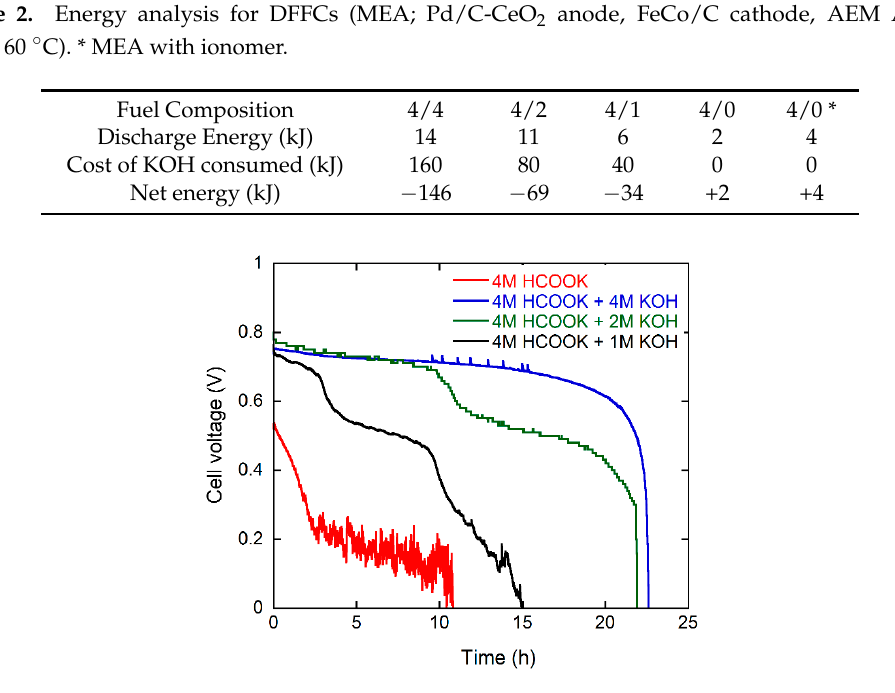
Figure 3. Galvanostatic curves at 50 mA·cm − 2 at 60 °C for the DFFC containing the Pd/C-CeO 2 anode, FeCo/C cathode, and fueled with 4 M HCOOK and various concentrations of KOH